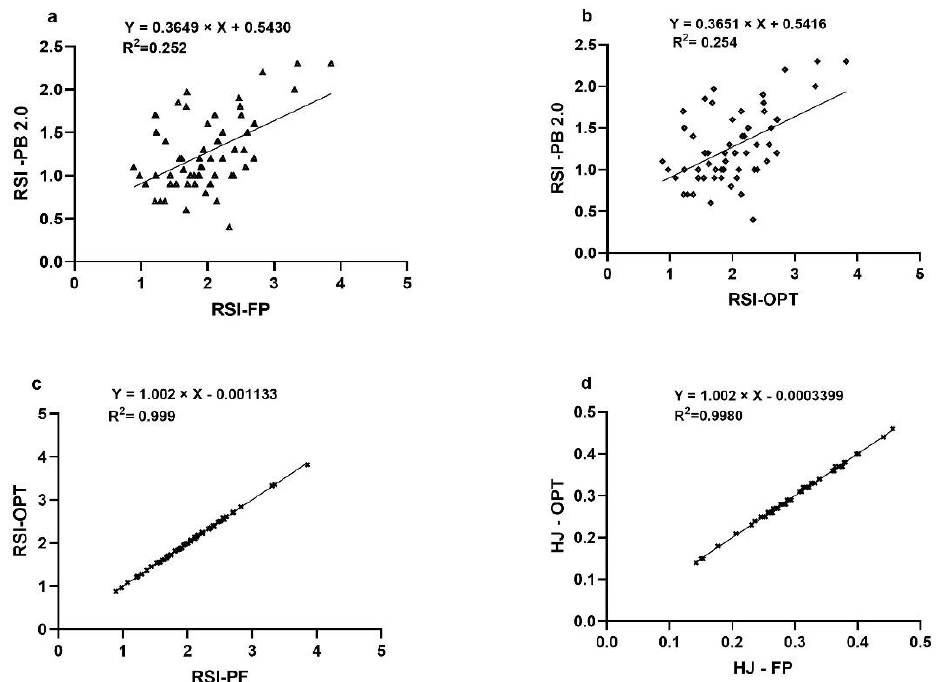
Figure 5. The R2 correlation coefficient analysis. ( a ) The R2 of RSI between PB2.0 and FP; ( b ) The R2 of RSI between PB2.0 and OPT; ( c ) The R2 of RSI between FP and OPT; ( d ) The R2 of HJ between PB2.0 and OPT.